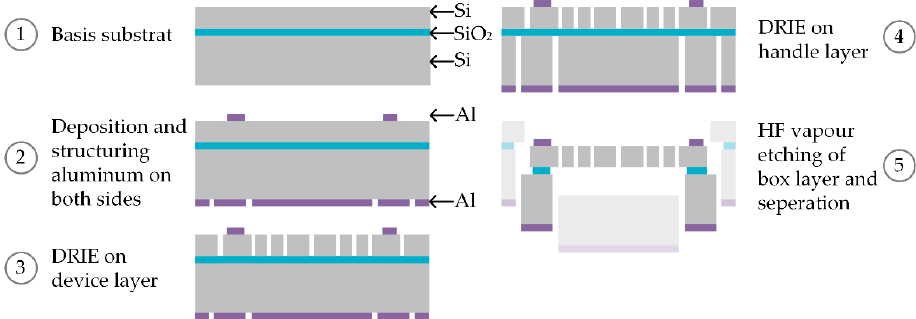
Figure 5. Schematic illustration of the workflow for the fabrication for a MEMS-based weighing cell based on a silicon-on-insulator substrate.